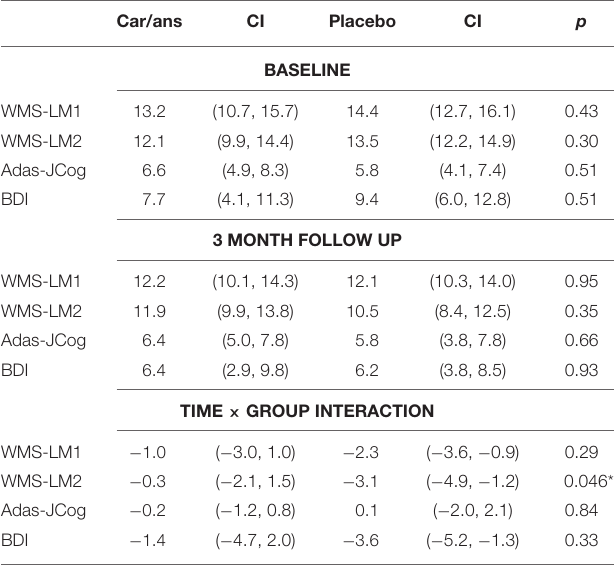
TABLE 3 | Neuropsychological test outcomes.